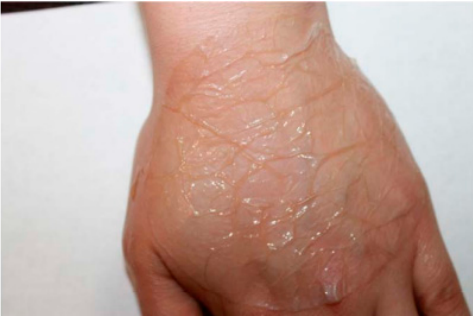
Figure 8. Transparency of microbial cellulose/honey sheet [62]. Reprinted from open source.